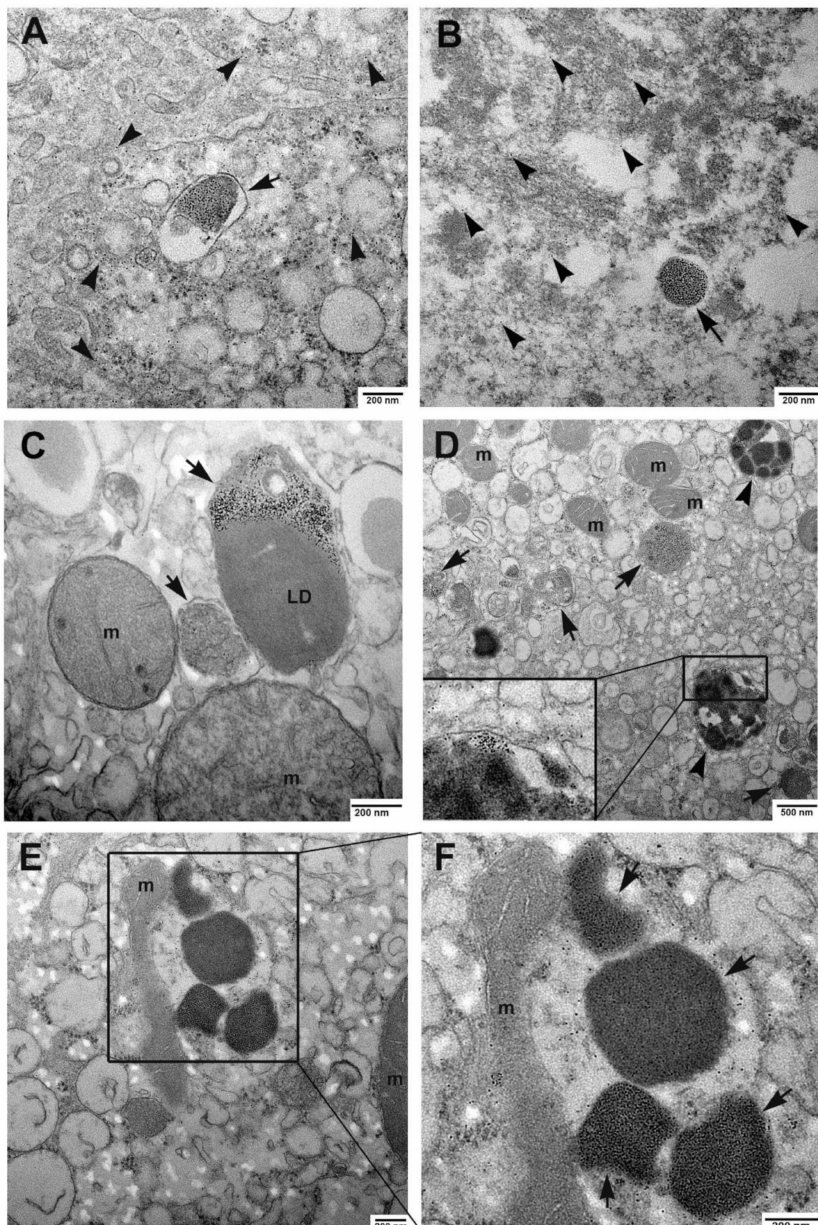
Figure 4. Ultrastructural analysis of iron accumulation in biopsies and autoptic livers. ( A ) Trans- mission electron microscopy of liver biopsies shows ferritin electron dense particles scattered in the cytoplasm of hepatocytes (arrowheads). Other particles are enclosed in siderosomes (arrow). ( B ) The analysis of autoptic liver sections reveals the presence of hemosiderin aggregates (arrow) and numerous ferritin particles diffuse in the cytoplasm. ( C , D ) Some siderosomes, beside ferritin particles, also contain lipid droplets or membranous structures (arrows); hemosiderin granules (arrowheads) are enclosed into organelles which also contain tiny ferritin particles (magnified boxed area in D). ( E , F ) Hemosiderin large aggregates are also found not segregated into siderosomes; higher magnification of the boxed area shows close contacts between hemosiderin aggregates (arrows) and a damaged mitochondrion; m, mitochondria; LD, lipid